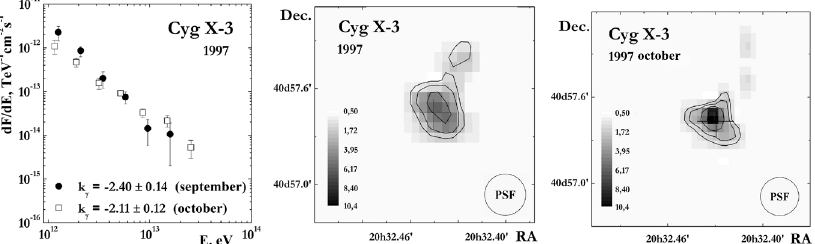
Figure 4. Di ff erential spectra of the γ -ray emission from Cyg X-3 during its flux increase in 1997. Images of Cyg X-3 at energies > 0 . 8 Figure 3. Di ff erential spectrum of the γ -ray emission from Cyg TeV during its flux increase in September and October of 1997. Figure 2. left: The SHALON light curve of Cyg X-3 folded with X-3 and image of Cyg X-3 at energies > 0 . 8 TeV during the flux the orbital period of 4.8 h. right: The di ff erential γ -ray spectra increase in 1995. for Cyg X-3 at very high energies in di ff erent intervals of orbital modulation. The lines represent the fit to each spectrum. Table 1. Test of the correlation between the data obtained in the SHALON observations of Cyg X-3 and at low energies.